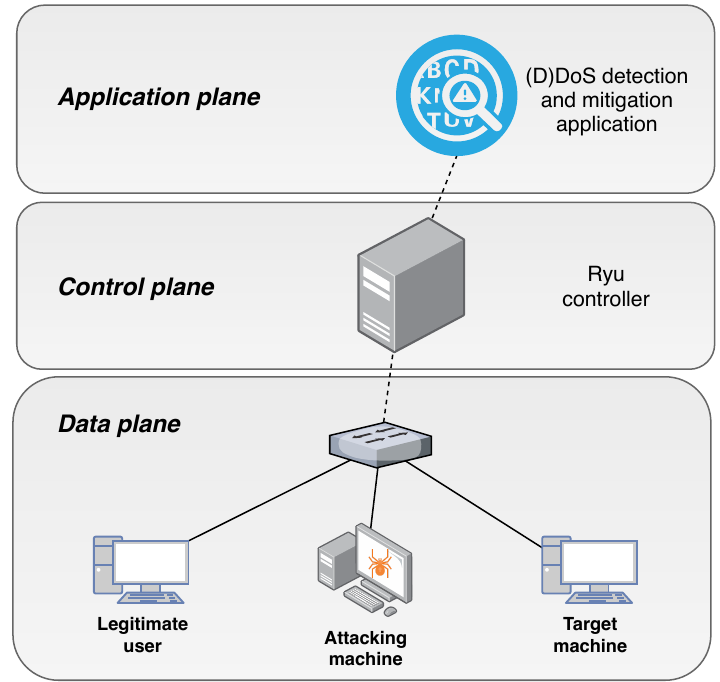
Figure 3. Testbed topology of the first scenario.